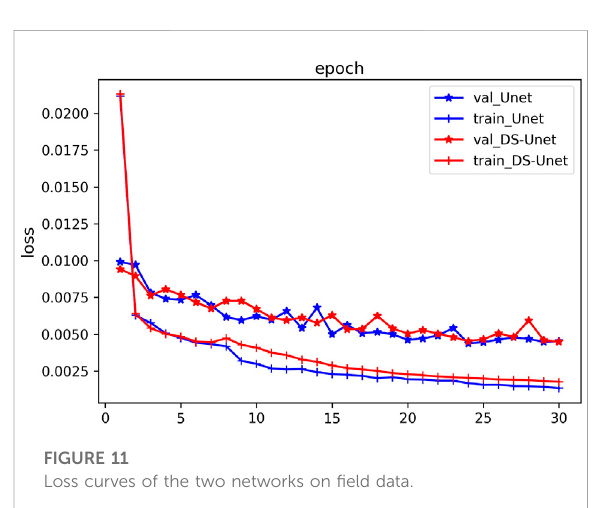
FIGURE 11 Loss curves of the two networks on fi eld